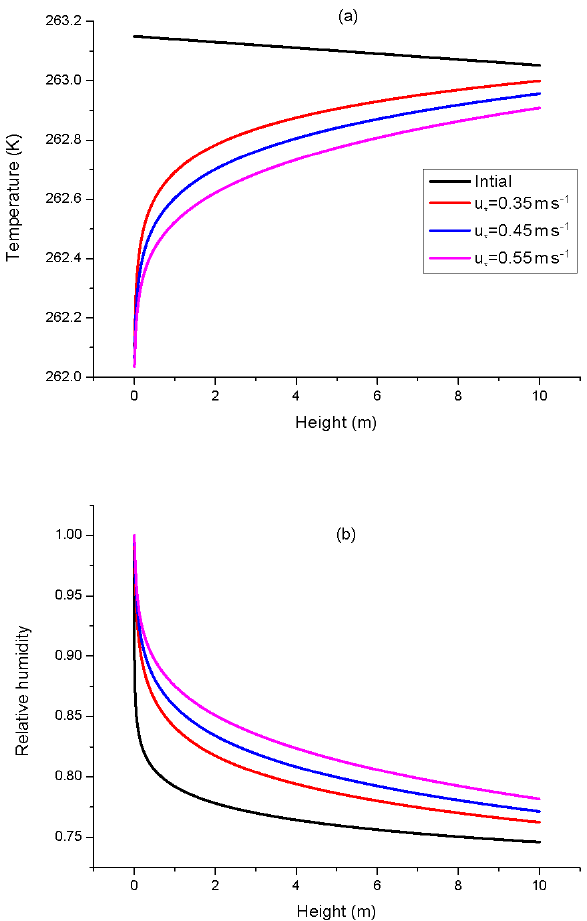
Figure 6. Vertical profiles of temperature and relative humidity.